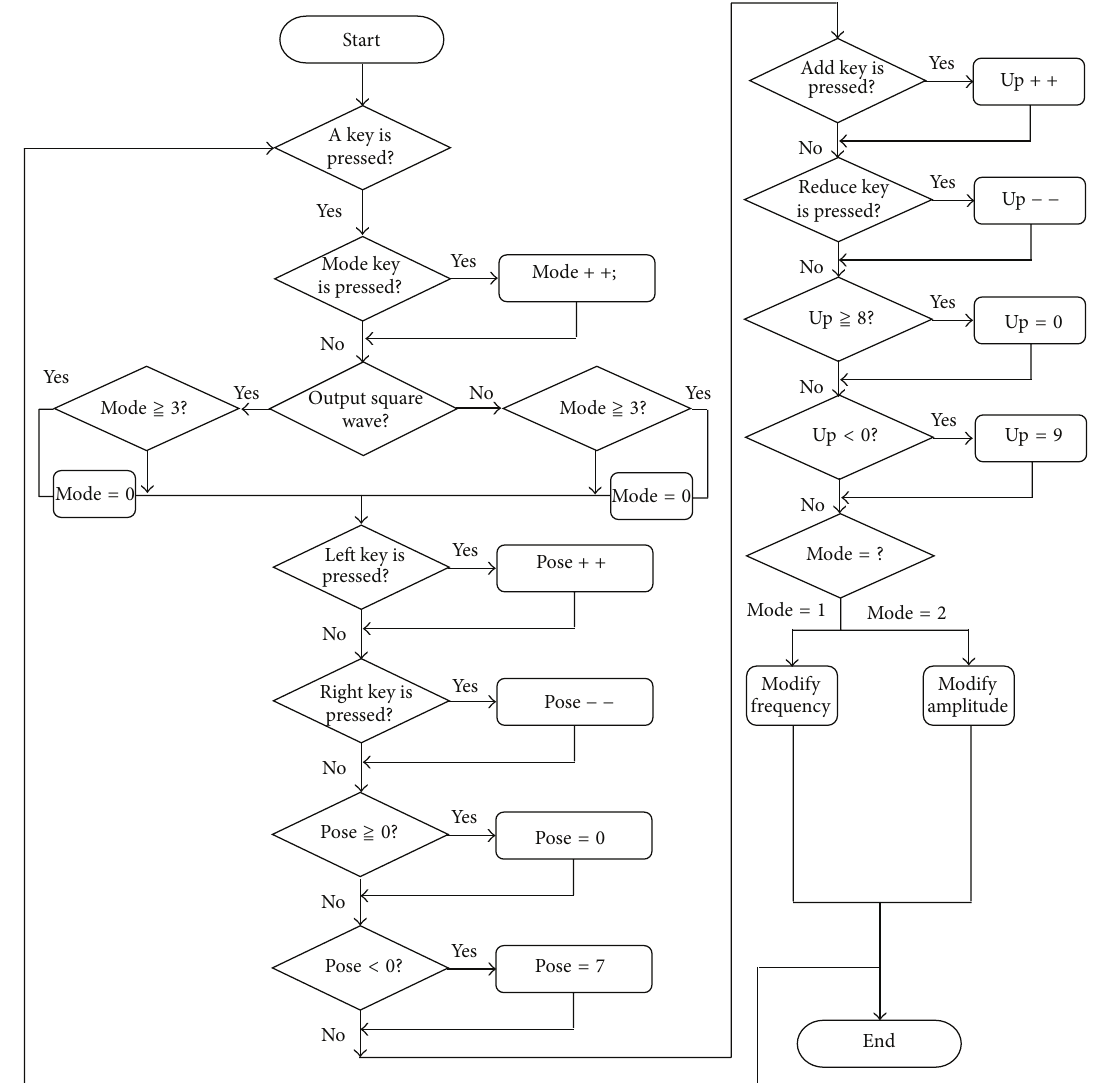
Figure 19: The block diagram of keyboard